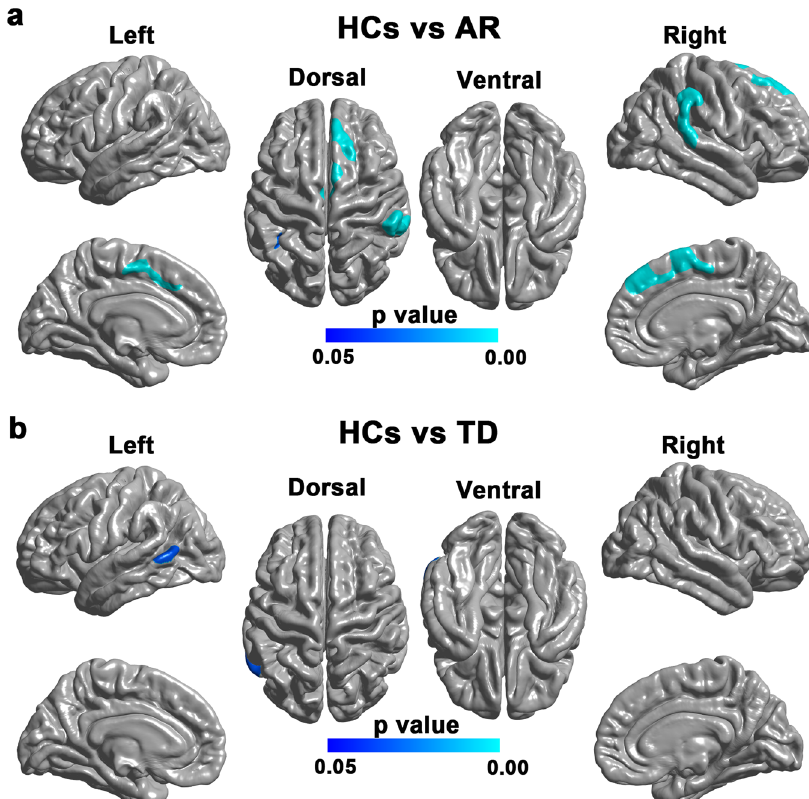
Fig. 1 Brain regions with reduced surface area in the AR and TD subtypes compared with HCs. a Brain regions showing signi fi cantly reduced surface area in patients with the AR subtype compared with HCs. The result was corrected for multiple comparisons using RFT. The color bar indicates the RFT-corrected p -value. b Brain regions showing signi fi cantly reduced surface area in patients with the TD subtype compared with HCs. The result was corrected for multiple comparisons using RFT. The color bar indicates the RFT-corrected p